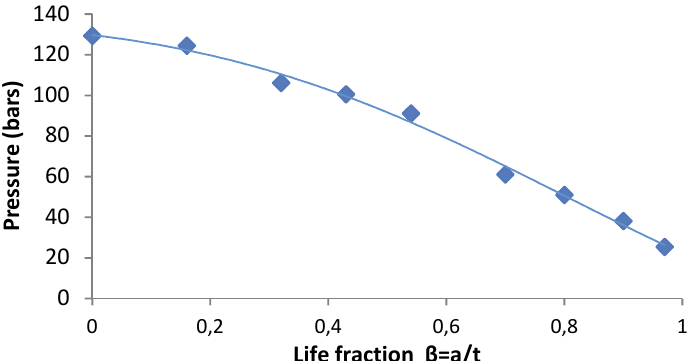
Figure 5: Ultimate pressure evolution in function of life fraction